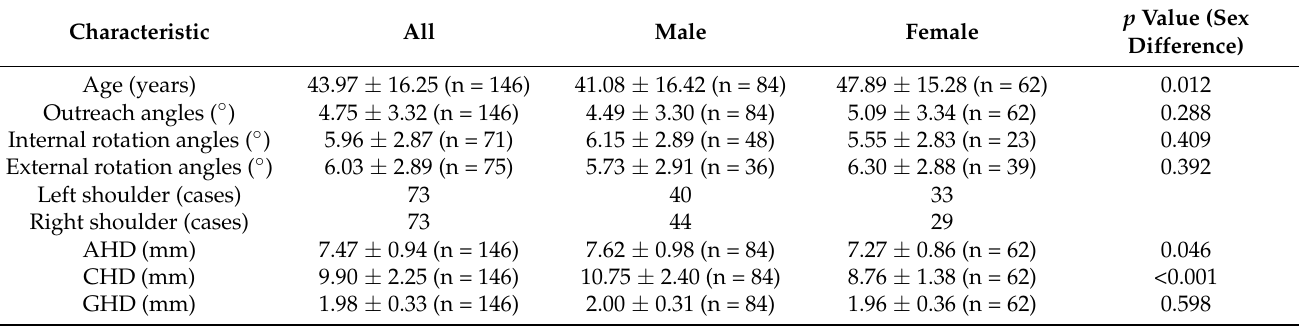
Table 2. Anticipant characteristics.